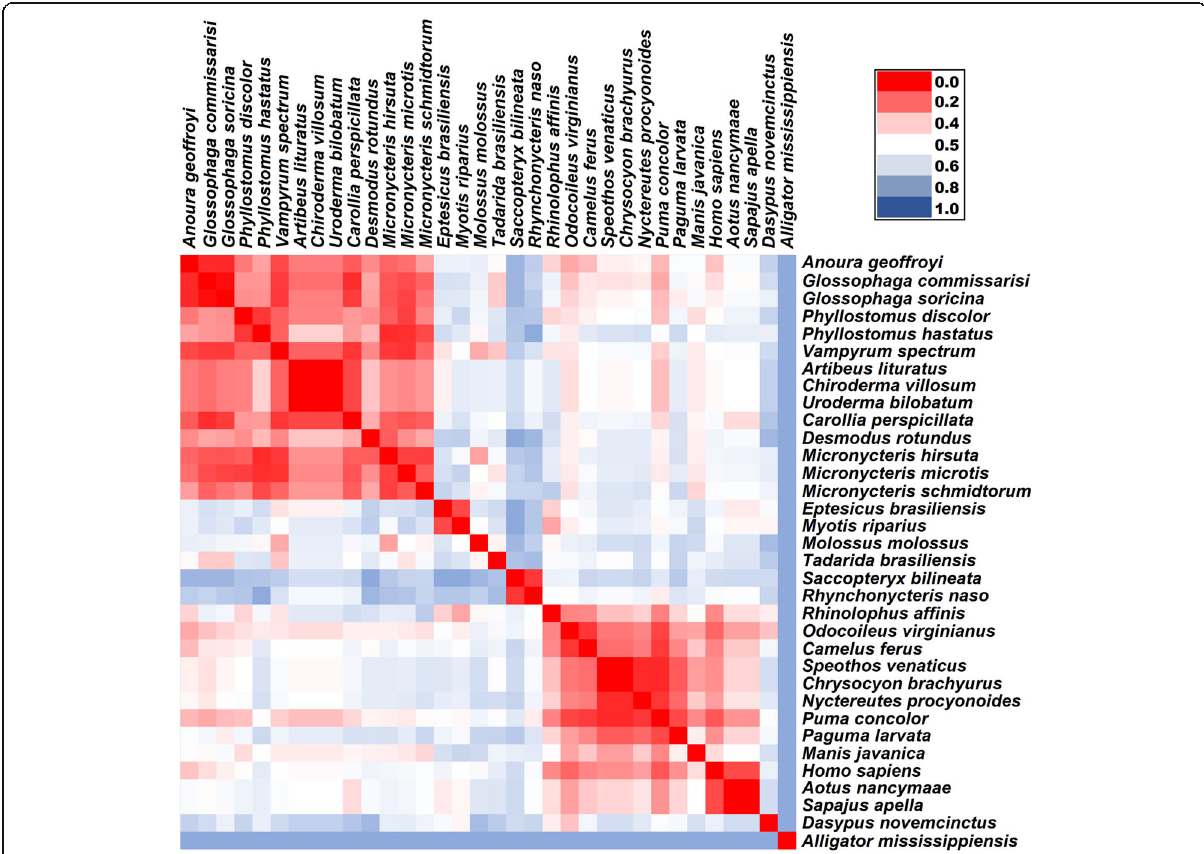
Fig. 2 Heatmap matrix was based on four ACE2 binding regions that encompass the key residues enabling interactions with the SARS-CoV-2 S protein, detailed on Table 2 and Supplementary file 1. The ACE2 binding regions were concatened and used to infer the evolutionary divergence values, represented in the matrix heatmap. The evolutionary divergence values are available in the Supplementary Table 2. The heatmap color gradients represent the evolutionary divergence based on the number of amino acid substitutions/site from a pairwise comparison between sequences, from low (red) to high (blue). Evolutionary divergence analyses were conducted using the JTT matrix-based model. The heatmap were constructed using the Microsoft Excel ™